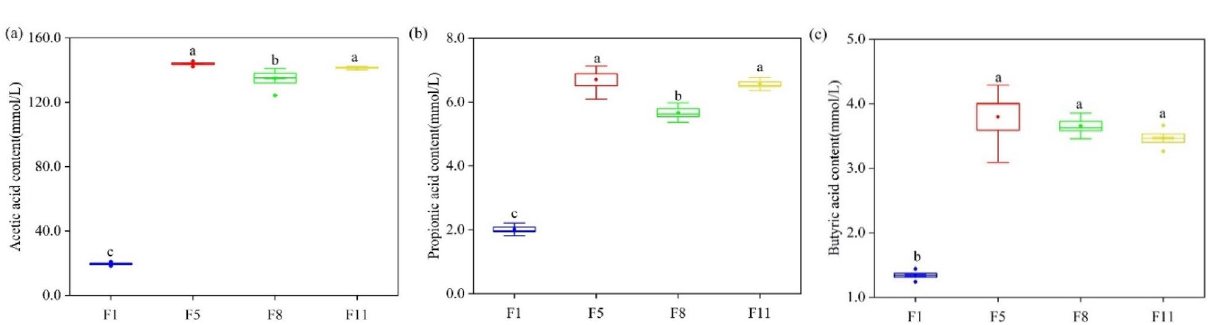
Figure 2. The ( a ) endoglucanase, ( b ) the filter paper enzyme, ( c ) xylanase, ( d ) laccase and ( e ) lignin peroxidase activity was measured at different culture stages.